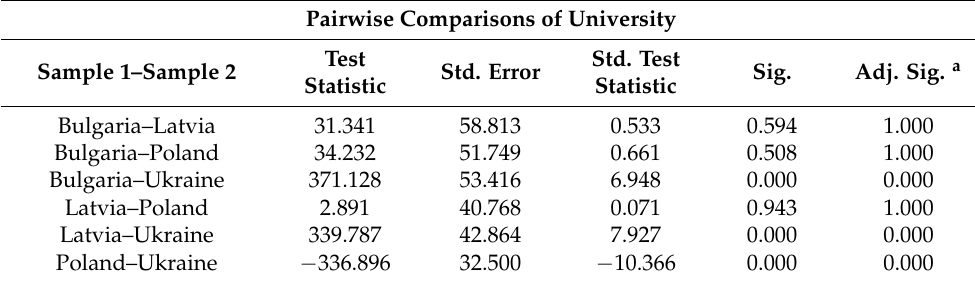
Table 3. Open Innovation Competence Profile—pairwise comparisons.